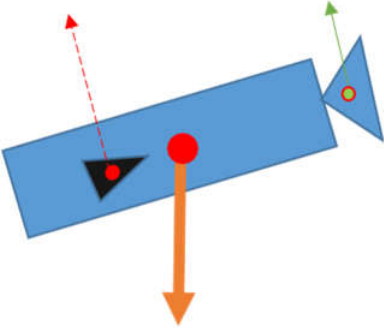
Figure 2. We apply u 0 while the pitch is not Figure 2. We apply   while the pitch is not zero.